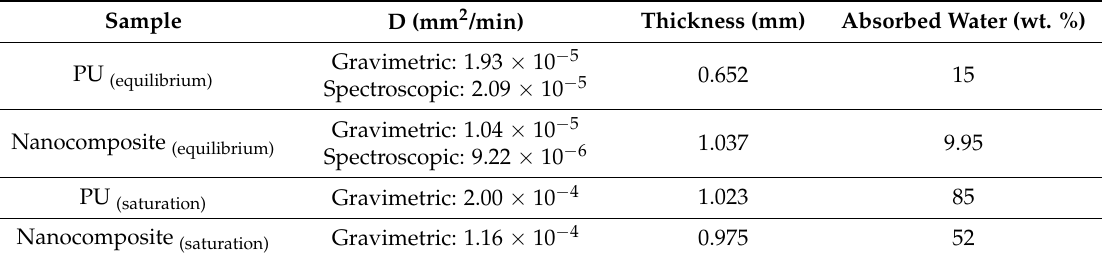
Table 1. Water diffusion coefficients (D) calculated for the systems under investigation at equilibrium and saturation .